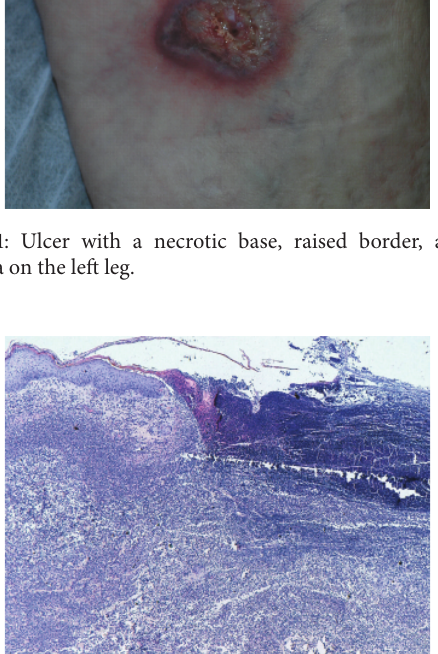
Figure 2: Neutrophilic abscess formation under areas of ulceration, as well as a dense inflammatory dermal infiltrate composed primar- ily of polymorphonuclear leukocytes (H-E × 10).